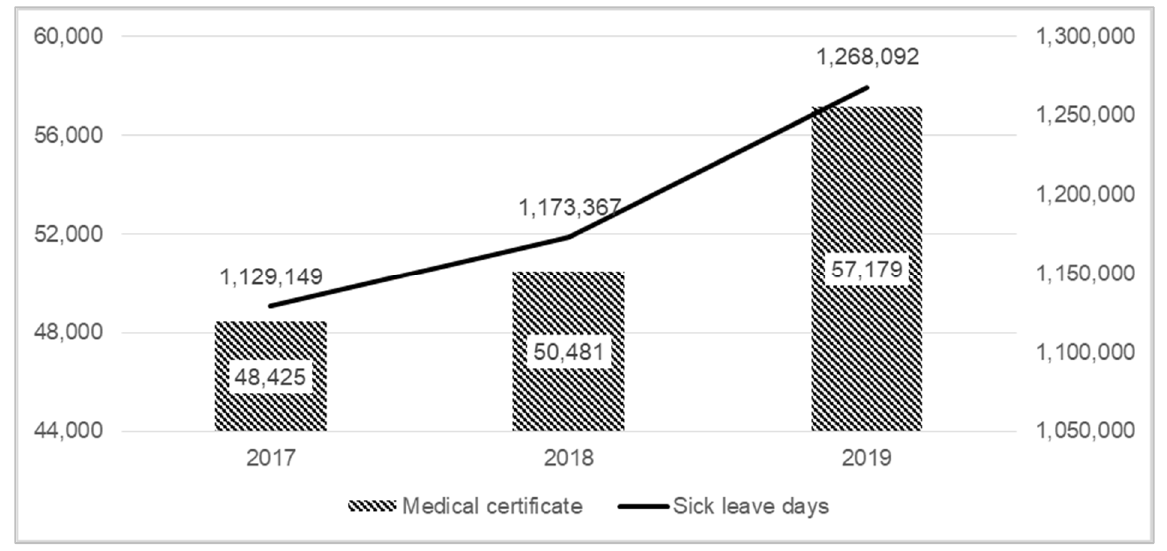
Figure 5. Sick leave days and medical certificate.